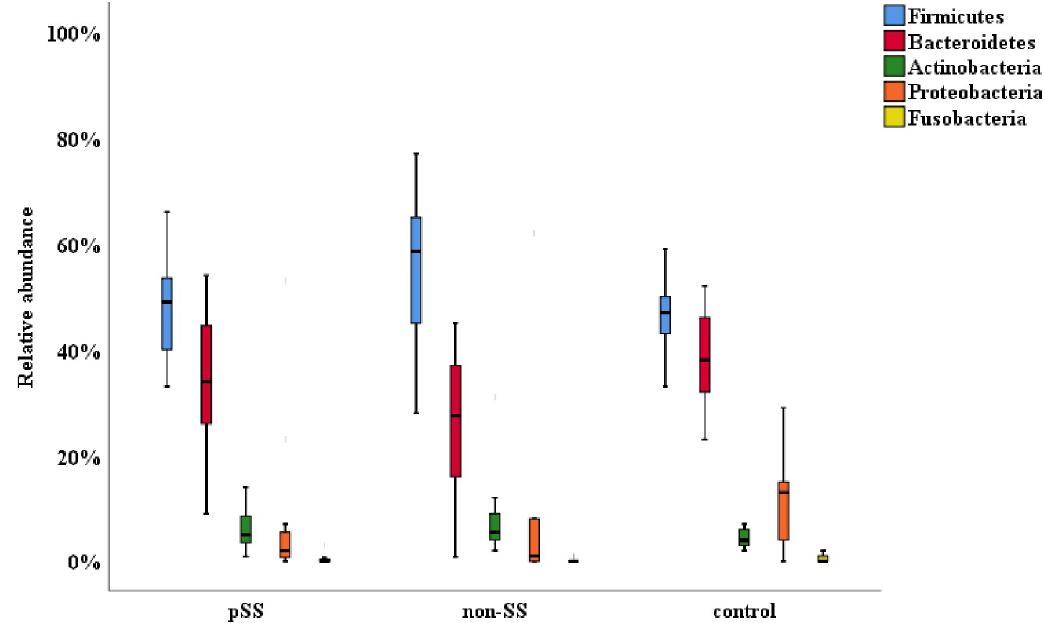
Fig 1. Relative abundance of the most major phyla in saliva from pSS, non-SS and control groups.